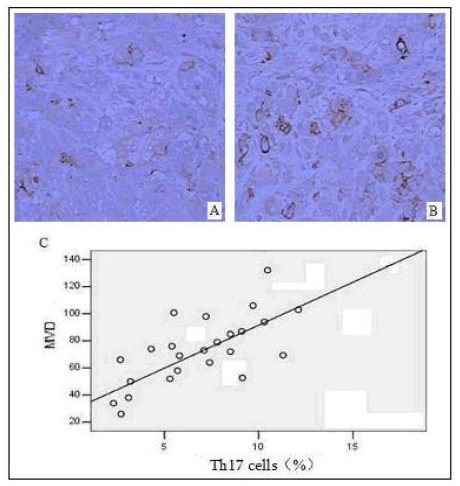
Correlation between distribution of Th17 cells in pancreatic tumor tissues and MVD; (A) Representative immunostaining of CD34 in tumor tissues from patients with a low percentage (2.86%) of Th17 cells in TIL (original magnification 200×); (B) Representative immunostaining of CD34 in tumor tissues from patients with a high; percentage (9.15%) of Th17 cells in TIL (original magnification 200×); (C) Positive correlation between distribution of Th17 cells in pancreatic tumor tissues and MVD (n = 24).